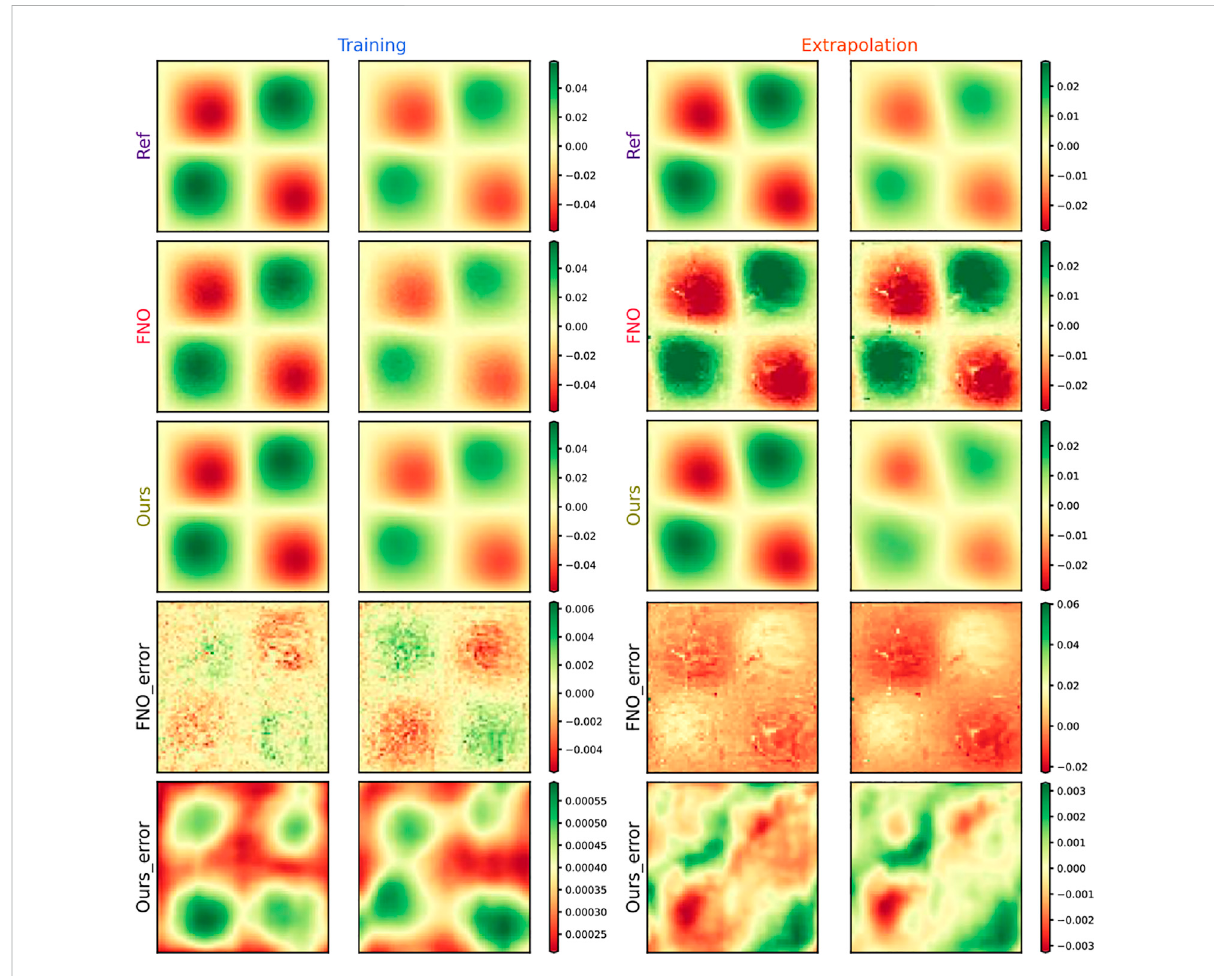
FIGURE 3 Result of PA_CasualLSTM solving Burger ’ s equation. Four representative moments are selected for comparison, namely, training ( t = 0.75, 1.5s) and extrapolation ( t = 2.5, 3.5s), and the entire interval error is compared. The sub fi gures from top to bottom are reference solutions, predictions by FNO and PA_CasualLSTM, and errors of FNO and PA_CasualLSTM, respectively.